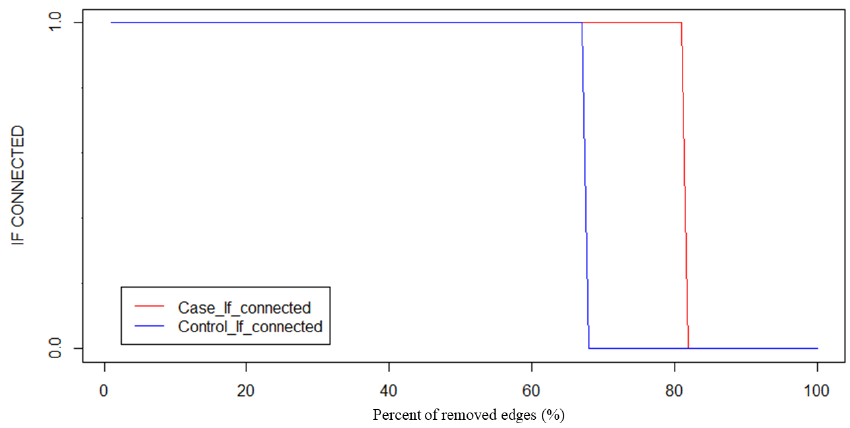
Figure 3. Threshold selection process (Example: under full-frequency band and PLI method).